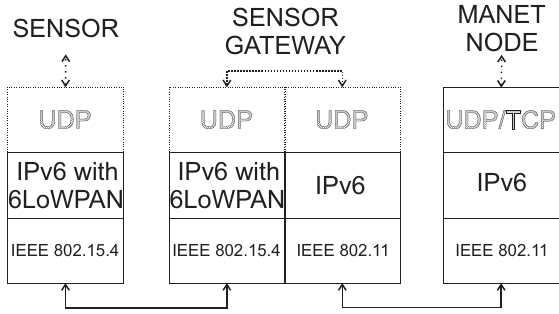
Figure 3. The example of dual protocol stack used in WSN gateway sensors.